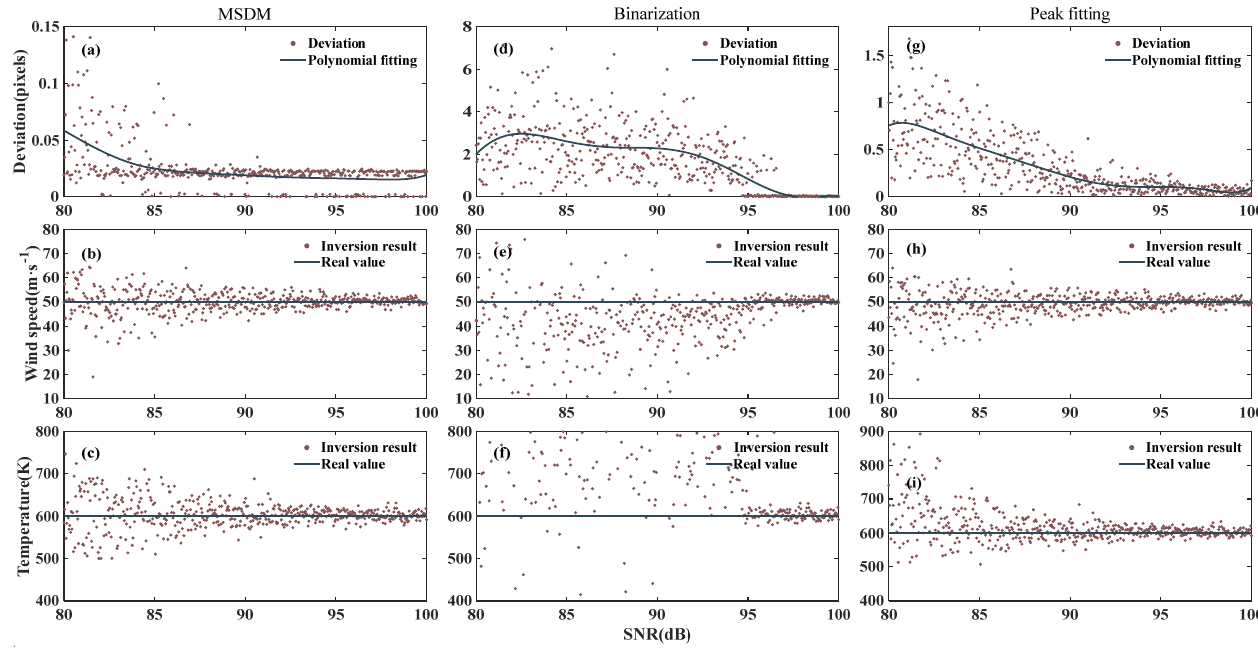
Figure 6. The top, middle, and bottom rows show the center deviation, wind, and temperature, respectively. The left, middle, and right columns are calculated using the MSDM, binarization, and peak fitting, respectively. The wind and temperature for each method use the center with deviations in the first column.